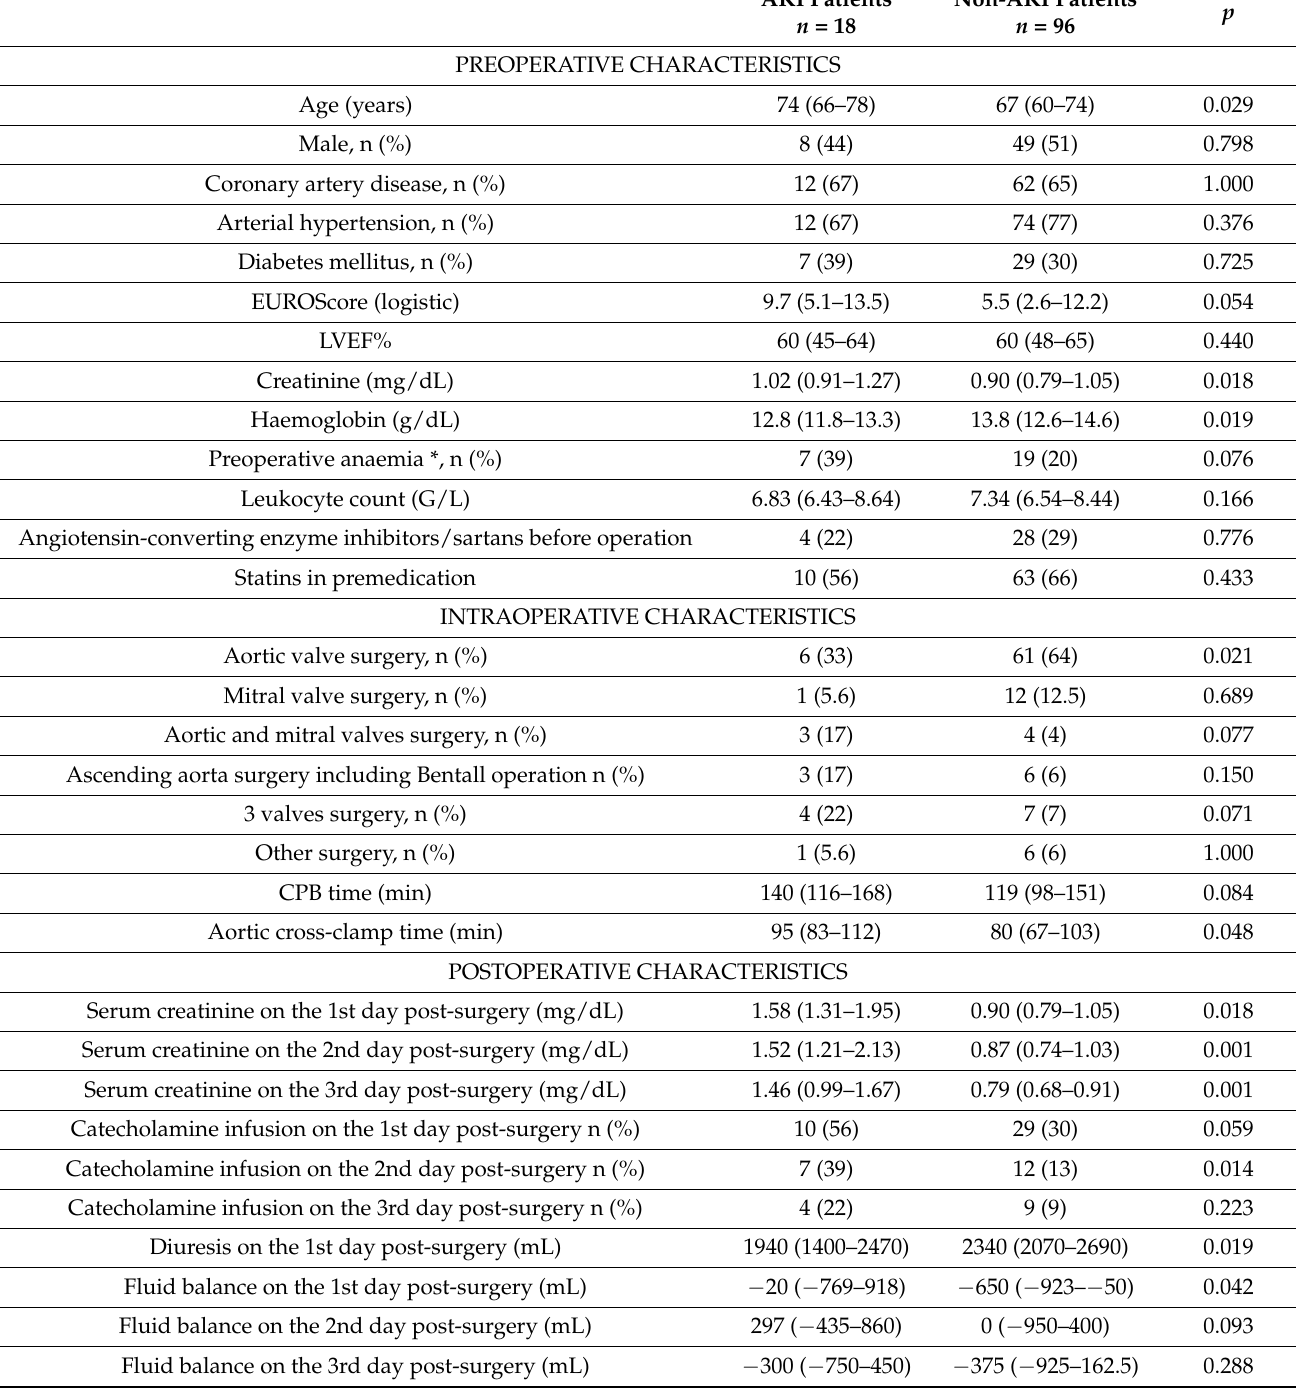
Table 1. Demographic, clinical, and laboratory characteristics and data of cardiac